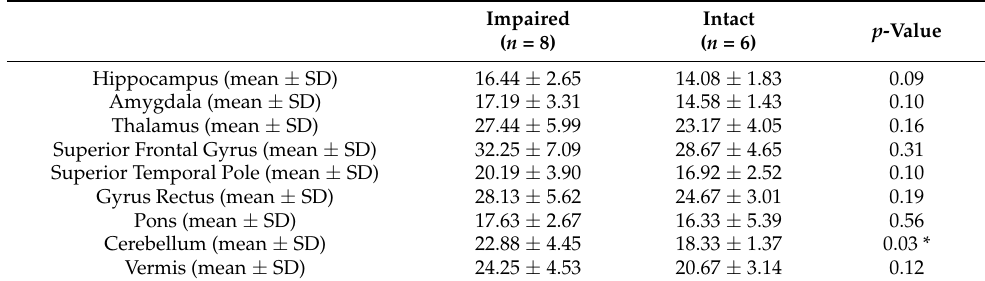
Table 2. Cerebral Metabolic rate of glucose ( µ mol 100 g − 1 min − 1 ) in the regions of interest in cognitively impaired and intact